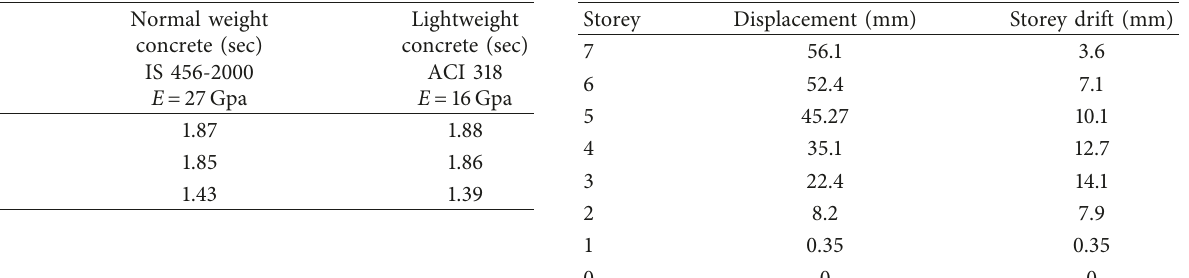
Table 7: Normal weight concrete.